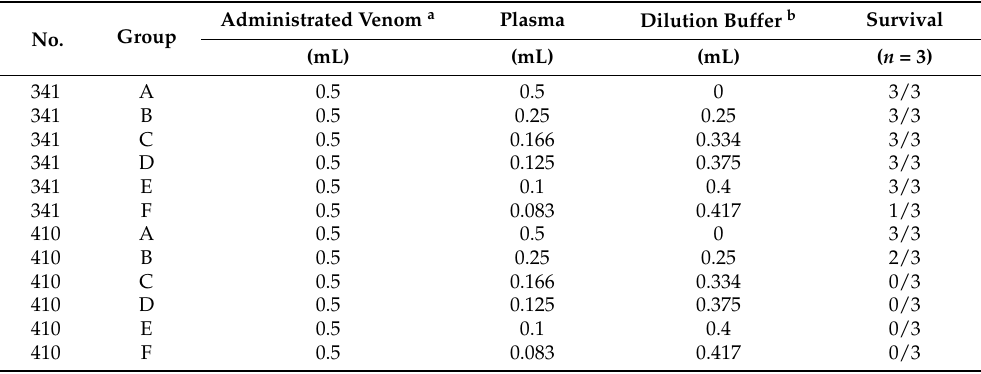
Table 1. Evaluation of neutralization potency of hyperimmunized equine plasma.